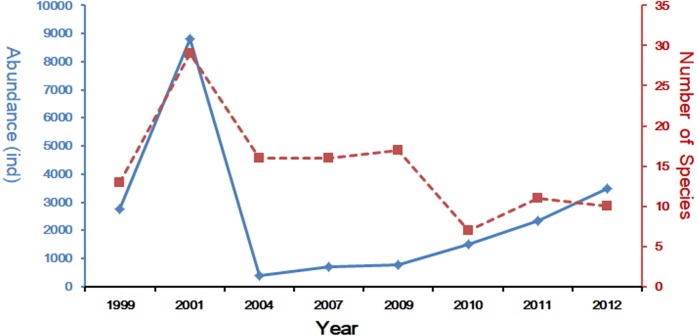
Spring long-term variation of the ichthyoplanton in Yangtze Estuary.The data for 1999–2011 was referenced from Zhang, Xian & Liu (2015) and Zhang, Xian & Liu (2016).